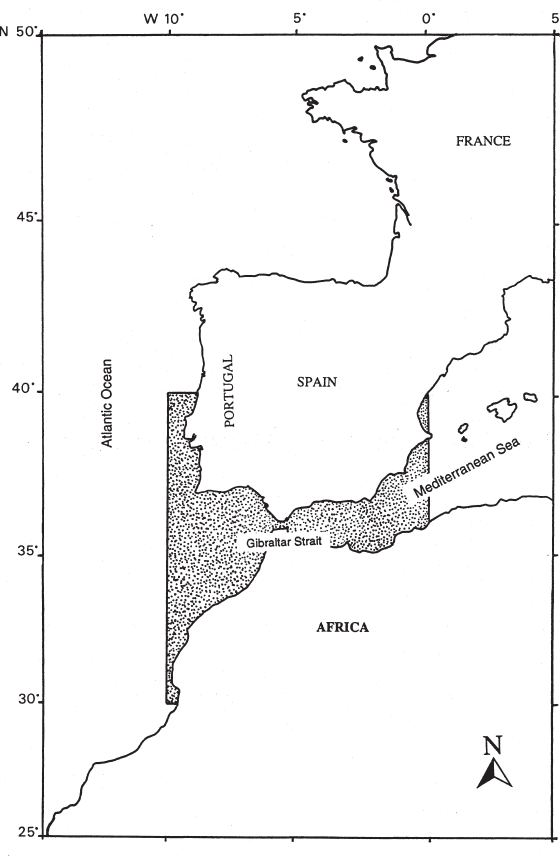
Fig. – 1. Map showing the location of the study zone (dotted